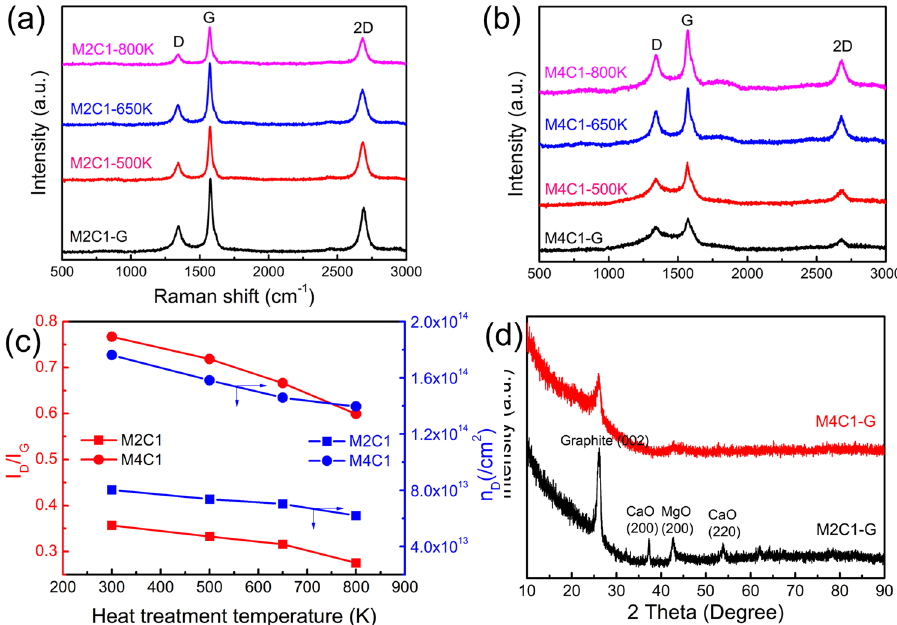
Figure 4. Raman spectra of M2C1 ( a ) and M4C1 ( b ) and the intensity ratios ( I D / I G ) (red) and the defect concentration n D (blue) of M2C1 and M4C1 corresponding to the heat treatment temperatures ( c ). XRD patterns of M2C1-G and M4C1-G at room temperature ( d